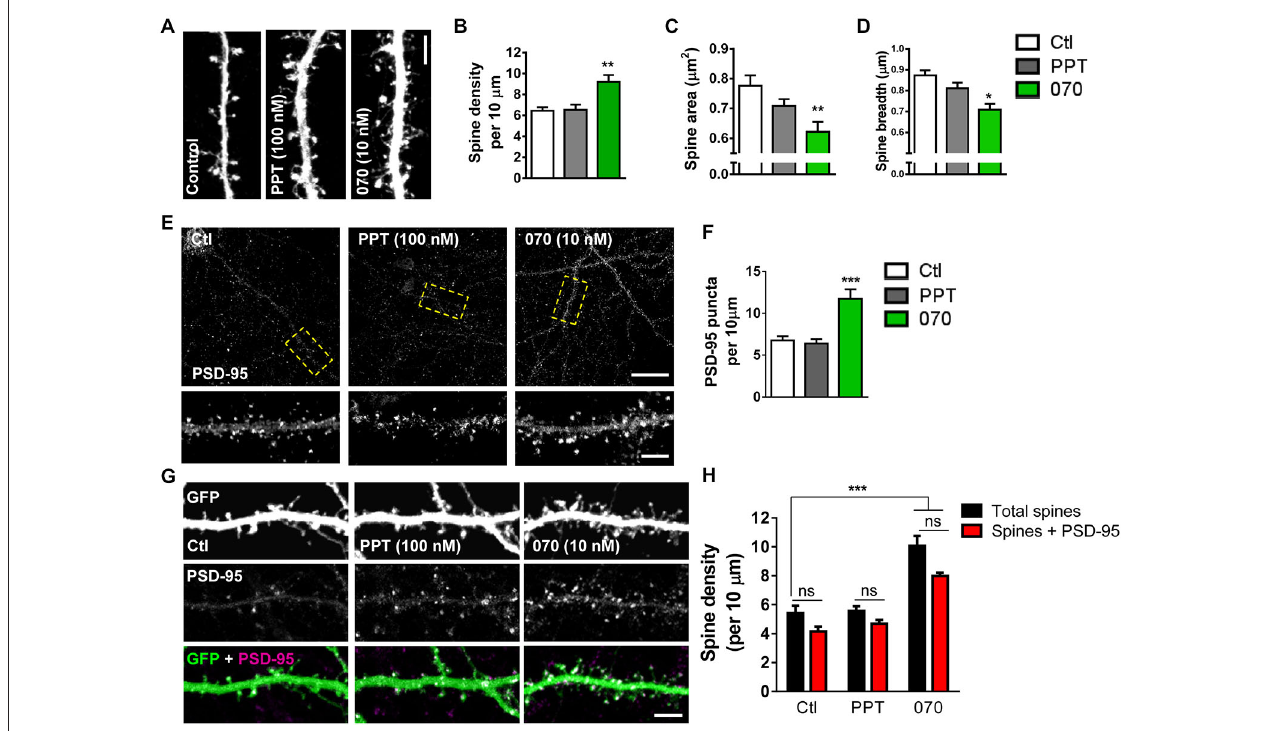
∗ p < 0.05; n = 11–15 cells per condition). (E,F) Confocal images of primary cortical neurons (DIV 25) immunostained for PSD-95; puncta linear density increased with treatment 070, but not PPT ( ∗∗∗ p < 0.001; n = 12 cells per condition). (G,H) Representative images of dendritic spines on eGFP expressing primary cortical neurons (DIV 25), co-stained for PSD-95, and quantified for number of PSD-95 containing dendritic spines following application of ER agonists. Activation of ER β (070) but not ER α (PPT) for 30 min resulted in an elevation of dendritic spines, and PSD-95 containing spine linear density ( ∗∗∗ p < 0.001 n = 15 cells per condition). Scale bar = 50 µ m (E) ; 5 µ m ( A,E inset, and G